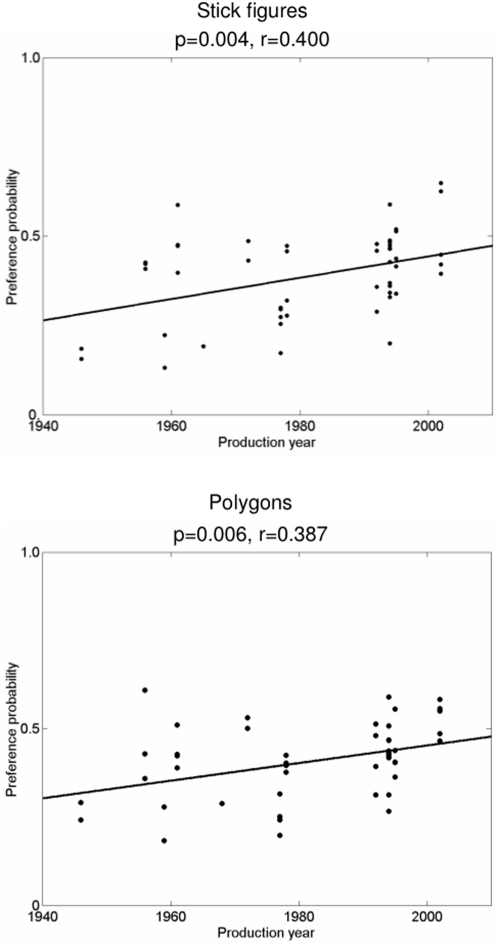
Results for the aesthetic preference experiment.Twelve naïve volunteers (without significant experience of performing or attending dance) viewed all possible pairings of stick figures/ polygons for each body position, and judged which image they preferred. A preference coefficient for each stick figure/ shape was then computed by averaging preferences across participants. This was defined as the probability of each figure or shape being preferred to all the other figures or shapes representing the same body position. Linear regression was applied to relate preference of each figure or shape to the year of the production from which each original image was selected. r and p values for the two analyses are given.